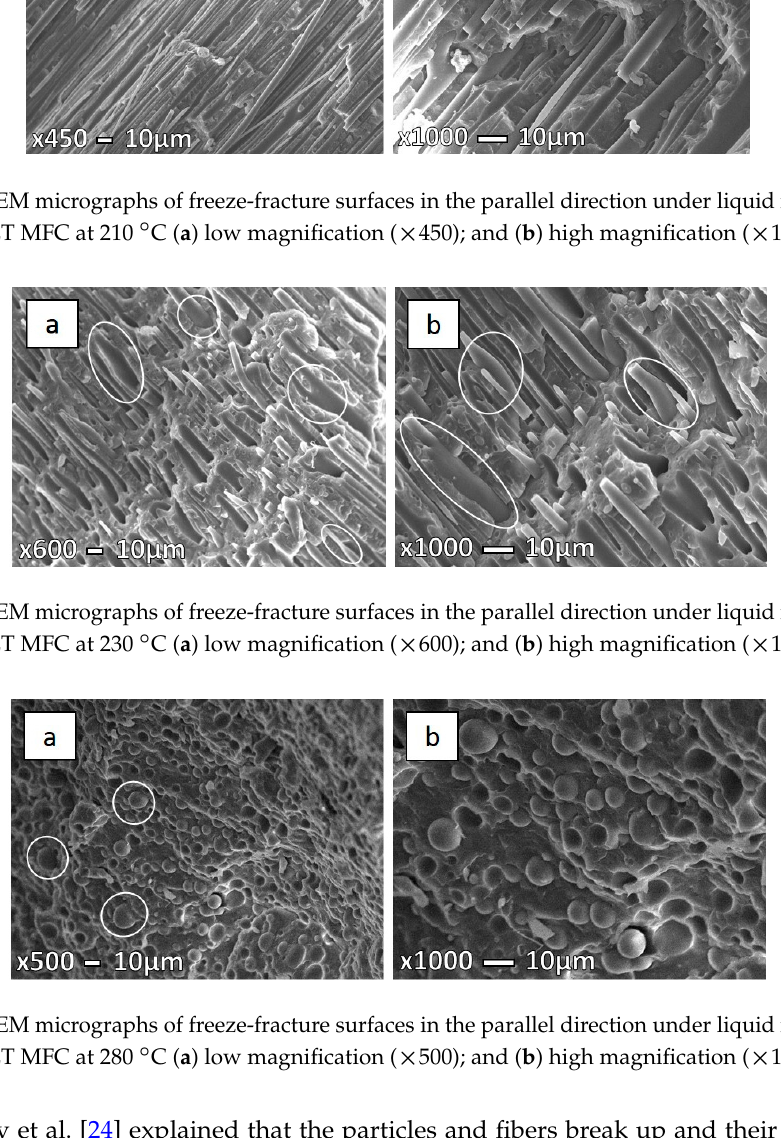
of 70PP/30PET MFC at 210 °C ( a ) low magnification (×450); and ( b ) high magnification (×1000).